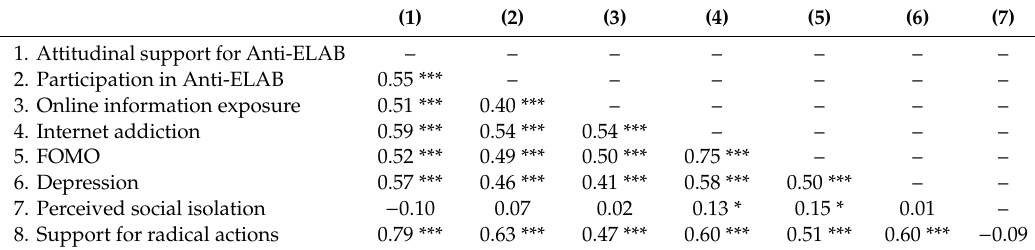
Table 2. Correlations of key variables.